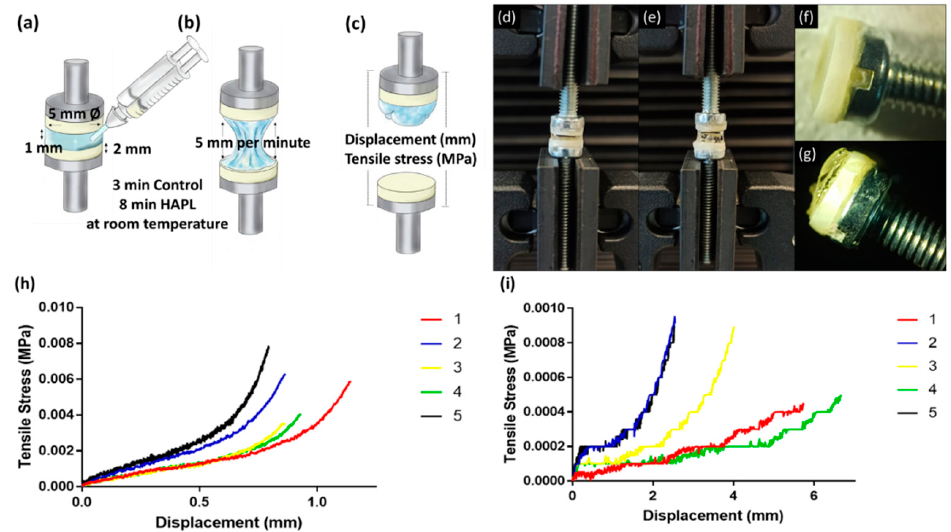
Figure 2. Tensile test. Schematic representation of the tensile test. ( a ) Loading of hydrogel in the 1 mm gap between the pre-conditioned dentin disks and zero-point position. ( b ) Dentin discs were continuously separated at a 5 mm per minute rate. ( c ) Breaking point values were registered after hydrogel loss of integrity or detachment from dentine. ( d ) Dentin disc glued to a screw head before the tensile test, and ( e ) sample prepared at the zero-point position, and ( f ) tensile test ongoing. ( g ) The hydrogel sample still adhered to the dentin disc after reaching the break point in the tensile test. ( h ) Tensile test graphic results of control hydrogel and ( i ) HAPL. Each line represents the tensile stress (MPa) curve of one individual sample.